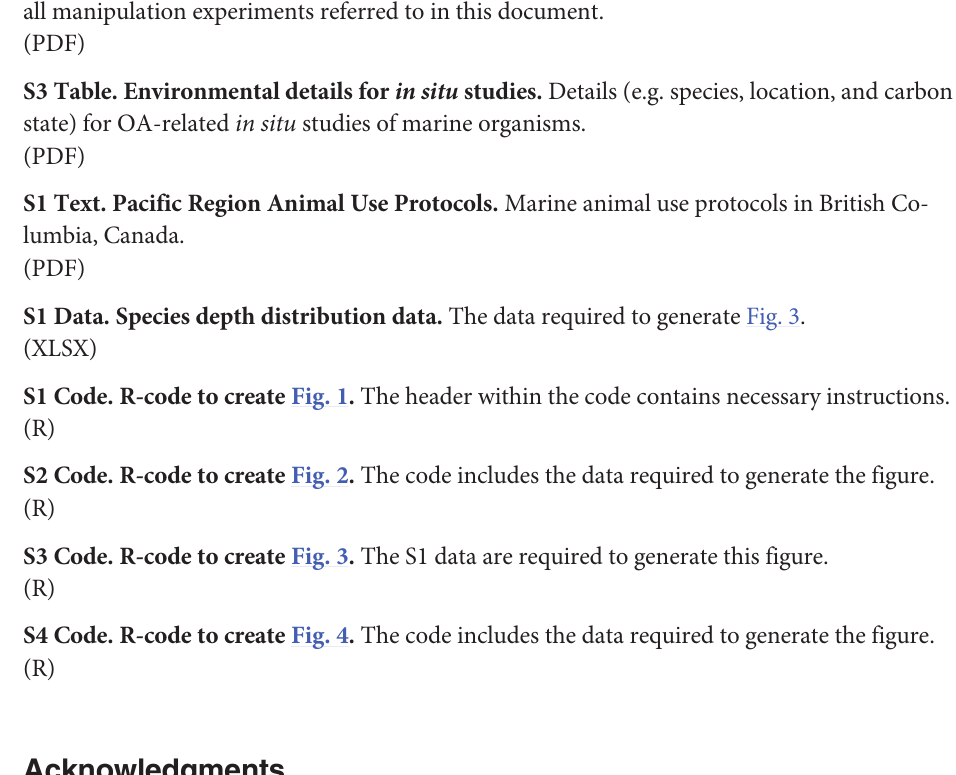
S2 Table. Experimental details for manipulation experiments. The experimental details for all manipulation experiments referred to in this document. S3 Table. Environmental details for in situ studies. Details (e.g. species, location, and carbon state) for OA-related in situ studies of marine